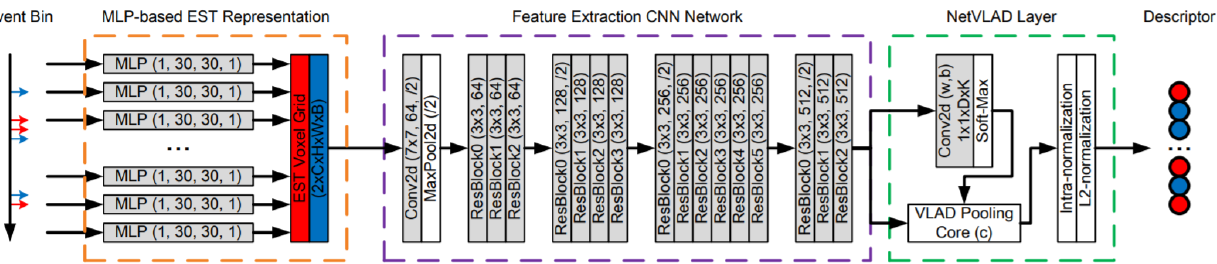
Figure 26. The pipeline of Event-VPR [79] for